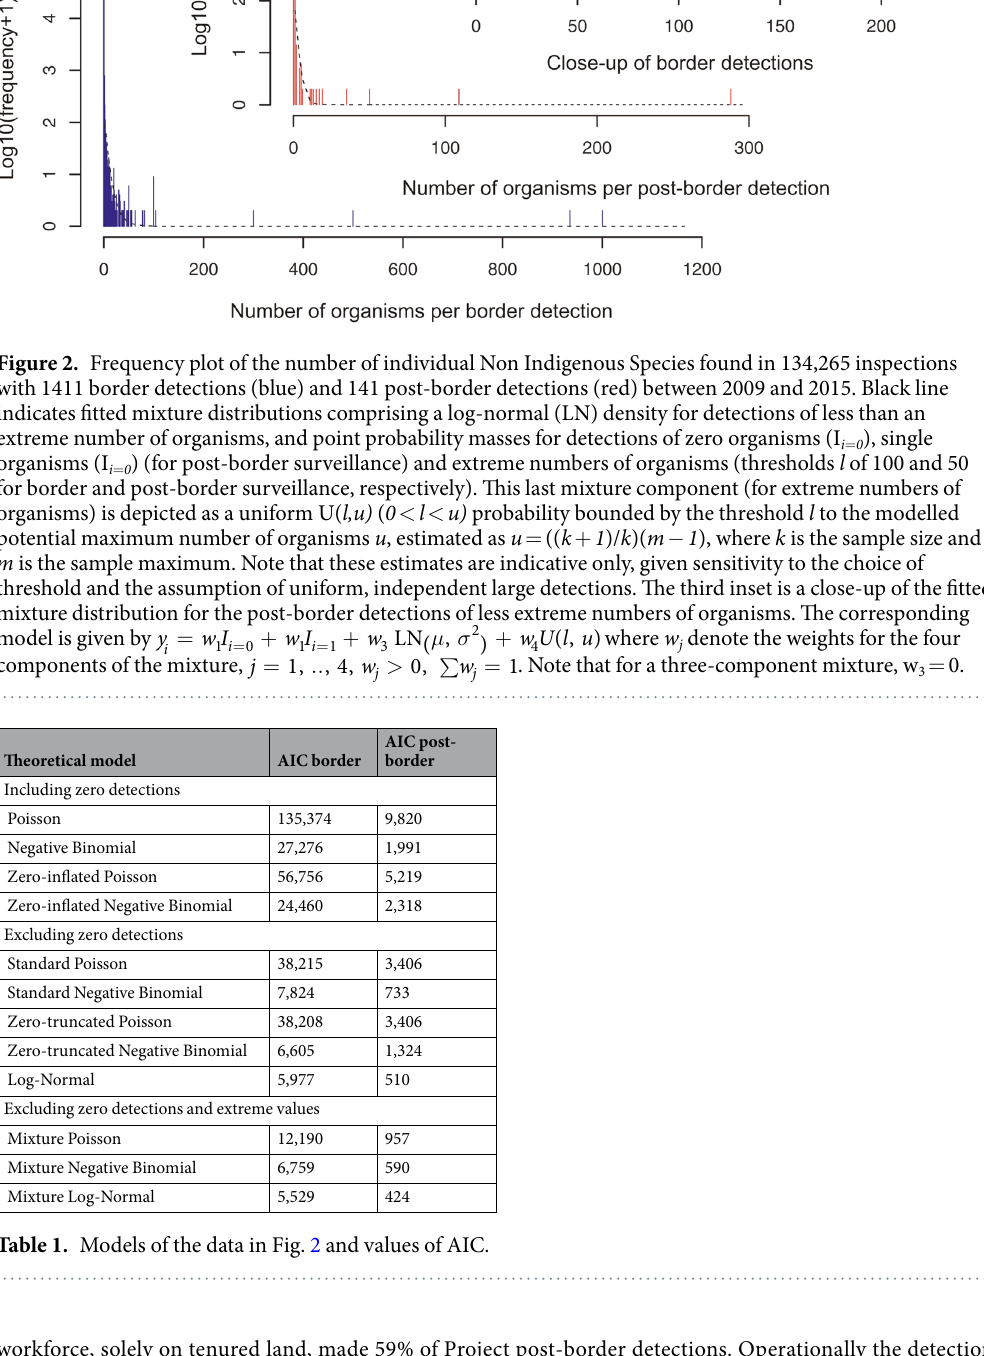
Post border detections.